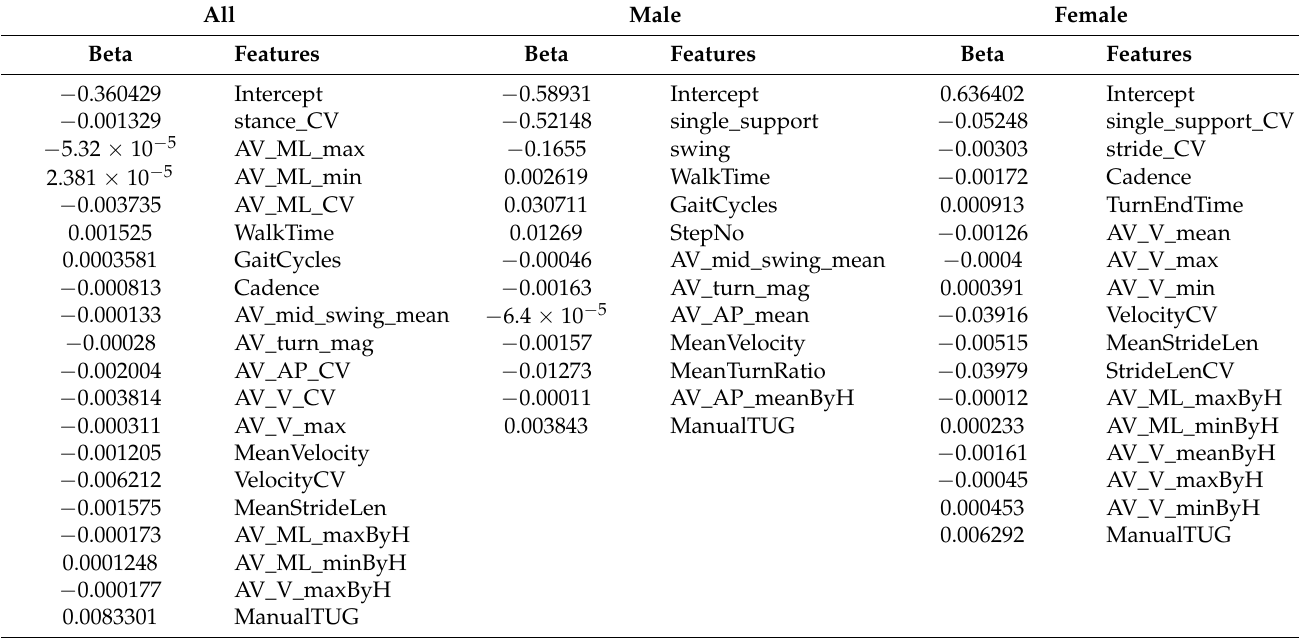
Table A11. TD-Fallers-NoPD falls count model coefficients. Beta refers to Poisson regression coeffi- cients, chosen through an elastic net procedure.